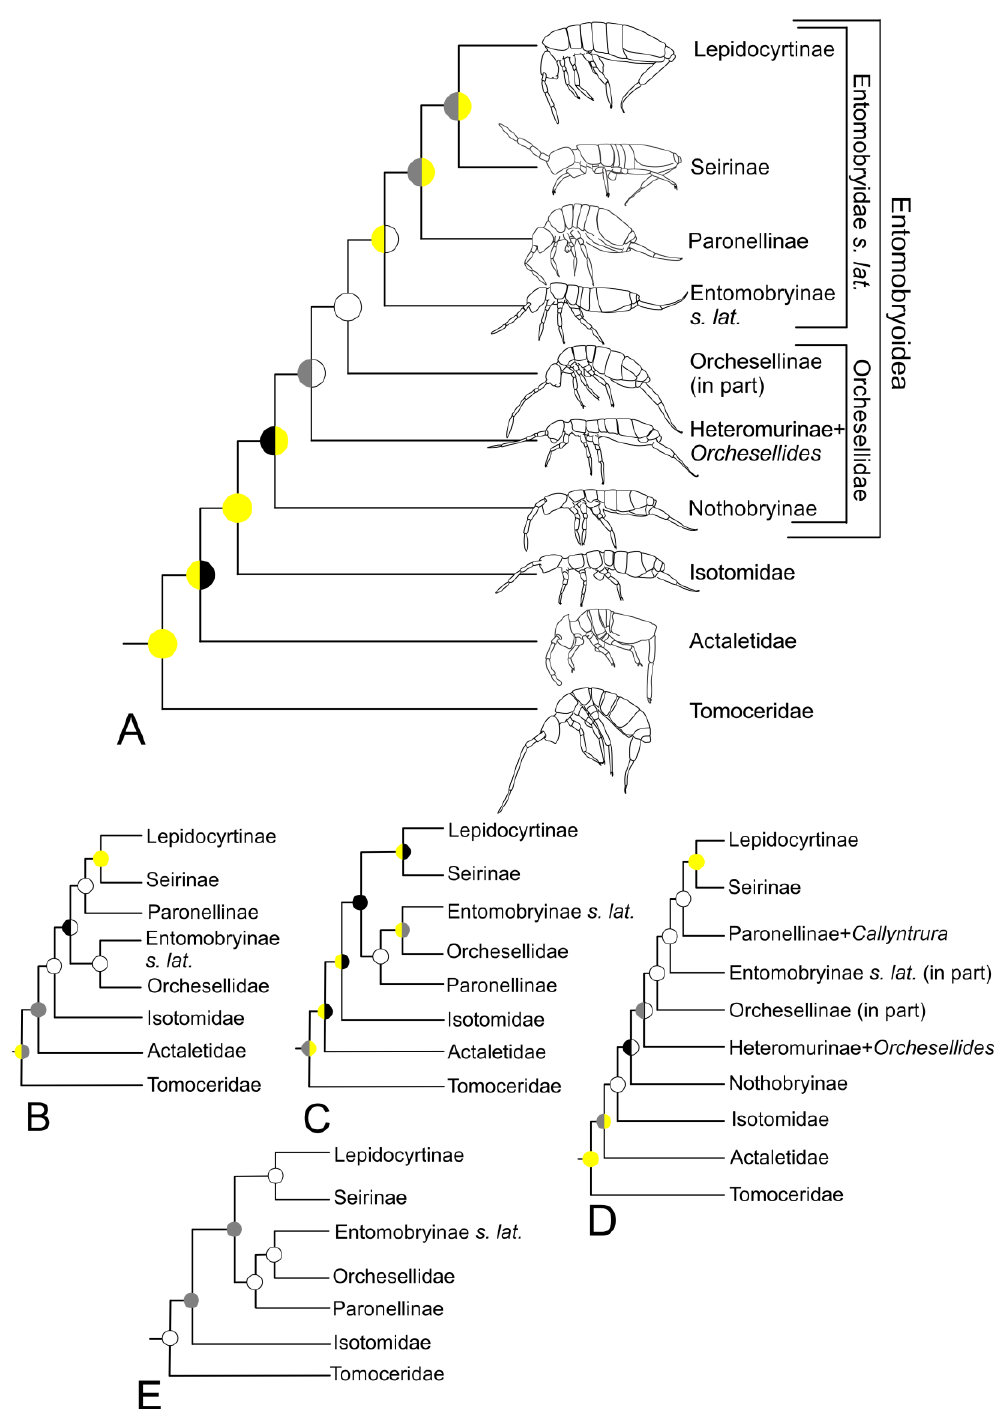
Figure 3. Summarized phylogenetic relationships of the higher Entomobryomorpha: ( A ) topology of ML_1 and BI trees (nodes depict only ML_1 support levels); ( B ) topology of ML_2 tree; ( C ) topology of ML_3 tree; ( D ) topology of ML_4 tree; ( E ) topology of MP tree (Actaletidae omitted since it was recovered outside of the main Entomobryomorpha branch). Node circles represent SH-aLRT support (left side) and bootstrap values (right side), respectively, for ML trees, and maximum parsimony bootstrap for MP tree. Colors represent the following scores: black = 100; yellow = 95 – 99.9; grey = 90 – 94.9; white < 90.